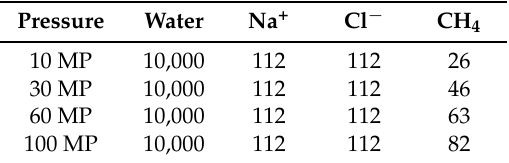
Table 5. The number of CH 4 and NaCl molecules used in the aqueous solution at 275 K.